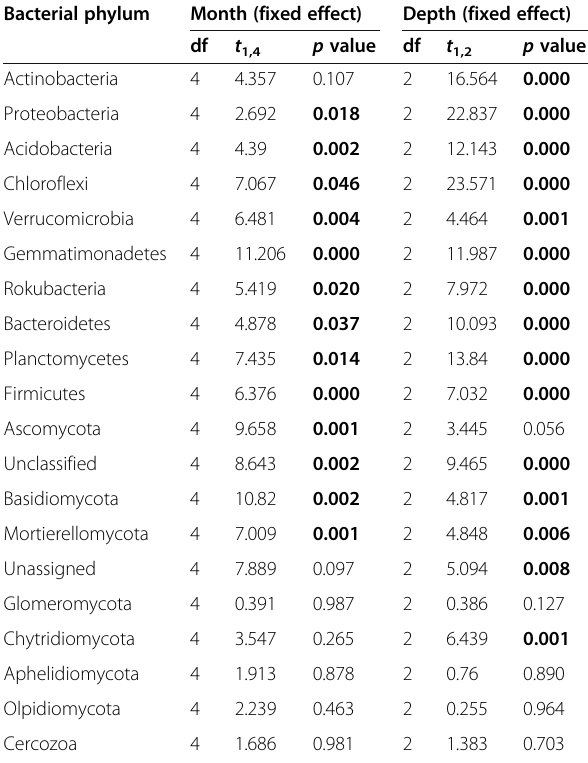
Table 2 GLMM results showing effects of month and depth on relative abundance of dominant bacterial and fungal phyla Bacterial